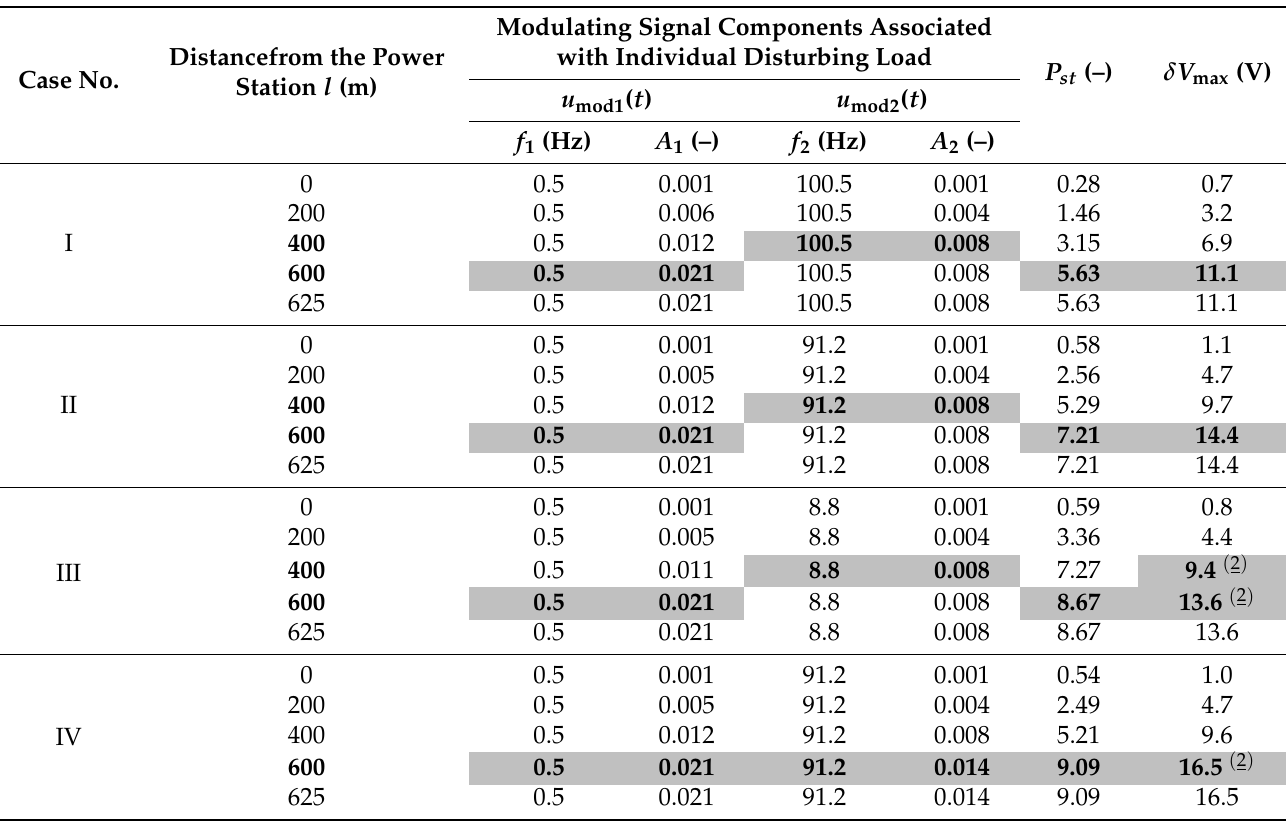
Table 8. The numerical simulation research results for Line